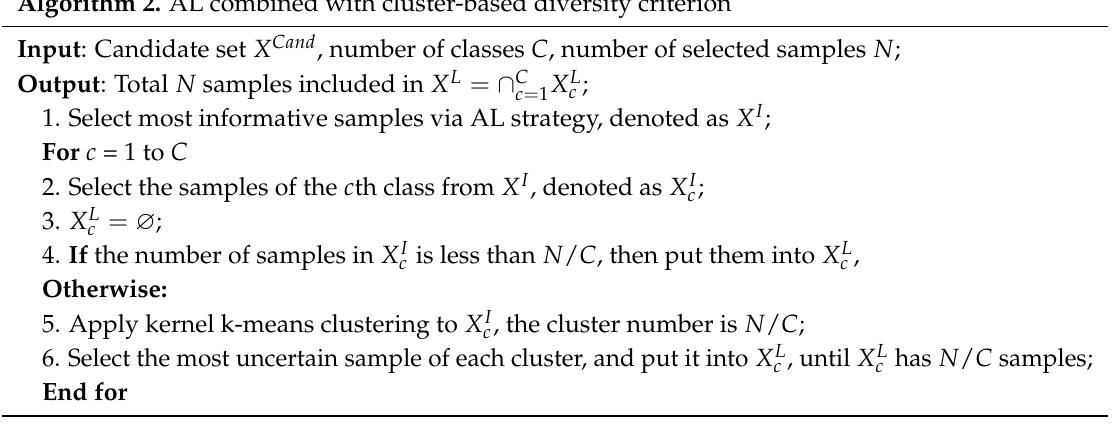
Algorithm 2. AL combined with cluster-based diversity